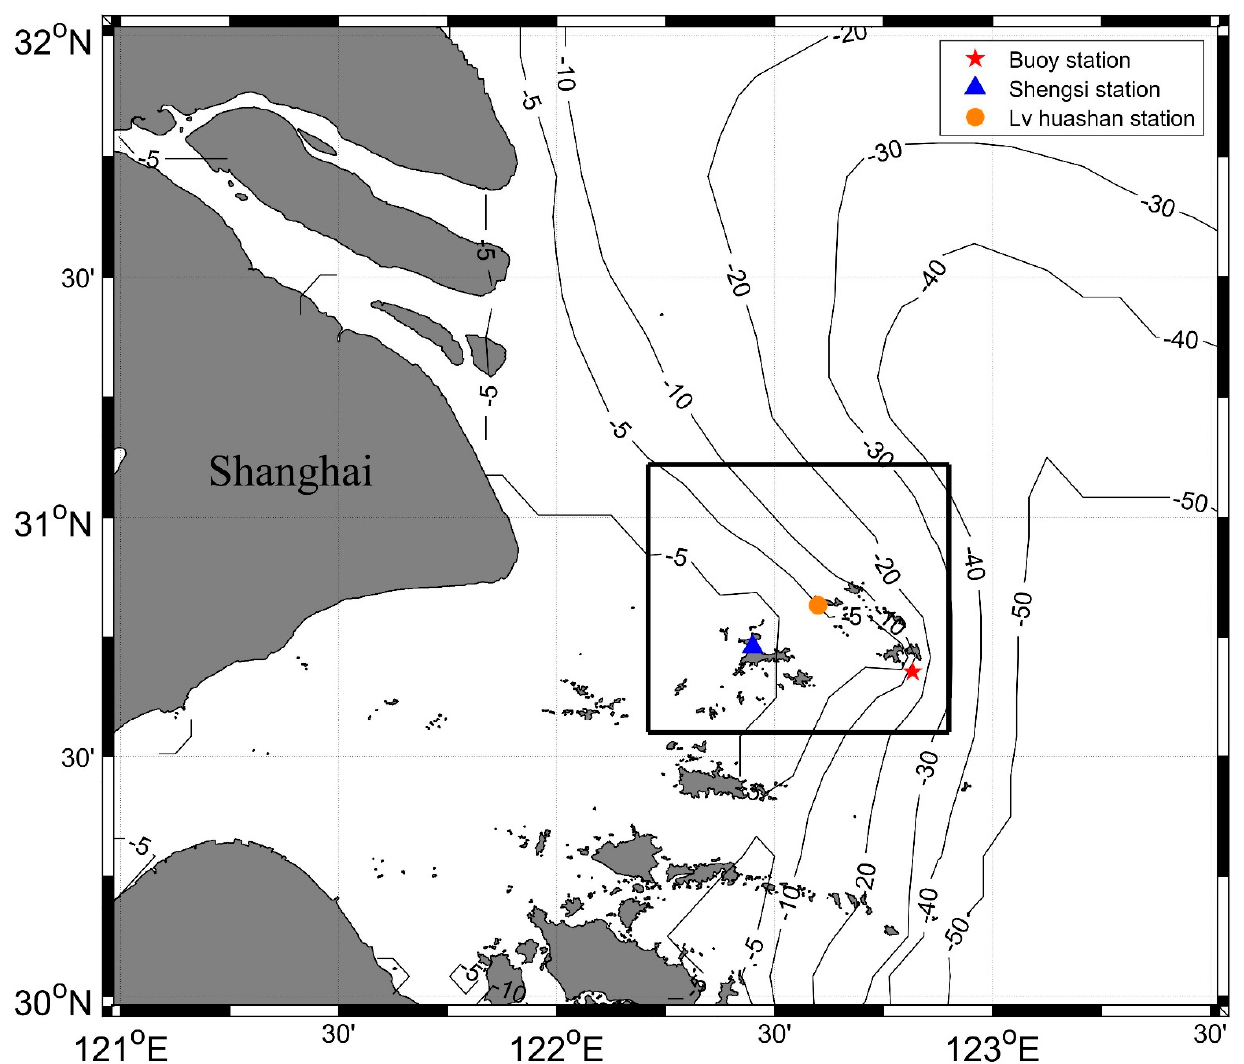
Figure 1. Locations of the optical buoy, Shengsi meteorological station, and Lv Huashan tide gauge station, with isobaths (units of meters) of the surrounding continental shelves. The black rectangle indicates the approximate range of a high- frequency red tide area out of the Yangtze Estuary [22].